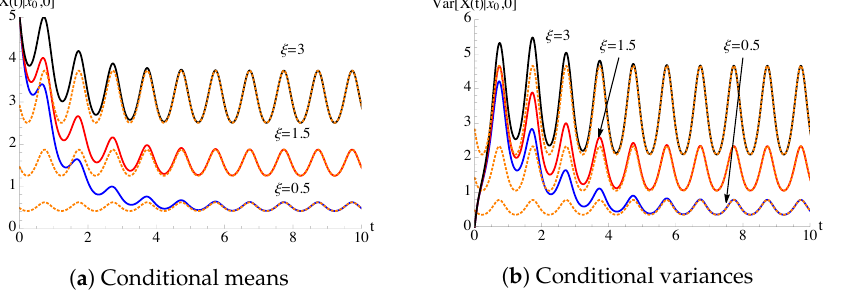
Figure 7. For the process (49), with x 0 = 5, r = 1, ξ = 1.5, η = − 1 and α ( t ) = η − 0.4 π cos (cid:0) (cid:1)(cid:3) − 1 0.2 sin 2 π t , the transition densities are plotted. The dotted functions indicate the corresponding asymptotic densities.